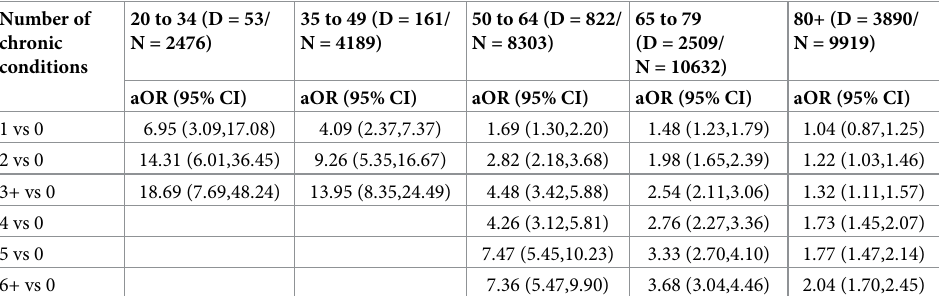
Table 4. Association between chronic condition count and death in hospital among adults aged 20+ years during first acute care hospitalization with a confirmed or suspected COVID-19 diagnosis in Canada by life-course age